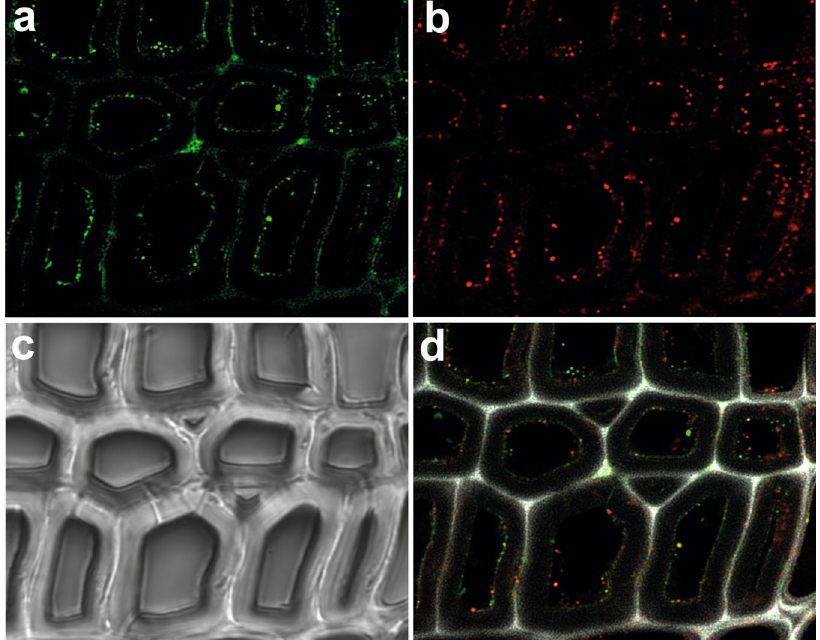
Fig. 6 | Localization of LPMO and CDH on wood cell walls. Fluorescence images show the binding of N. crassa CDHIIA and LPMO9C onto poplar wood cell walls. a Fluorescence from DyLight D550-labeled CDH, and b fl uorescence from DyLight